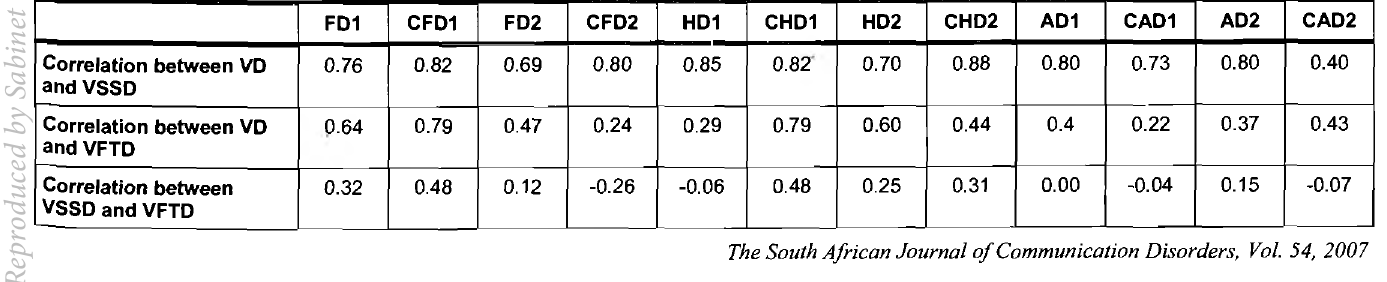
Table 4: Correlation coefficients between the durational parameters of vowel duration, vowel teady state duration and vowel formant transition duration FD1 CFD1 FD2